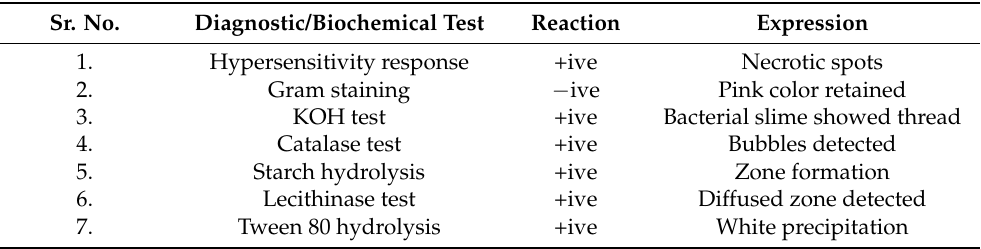
Table 1. Identification of Xcm through biochemical and diagnostic tests on nutrient agar medium and indicator